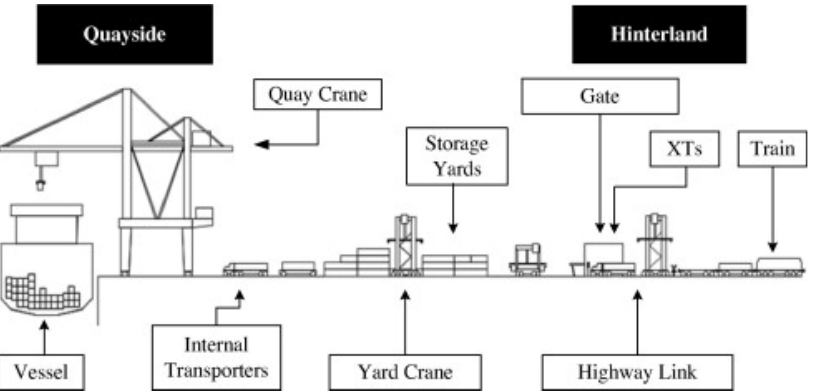
Figure 1. Schematic diagram representing the typical layout of a container terminal. ( XTs: refers to external trucks) [4] .